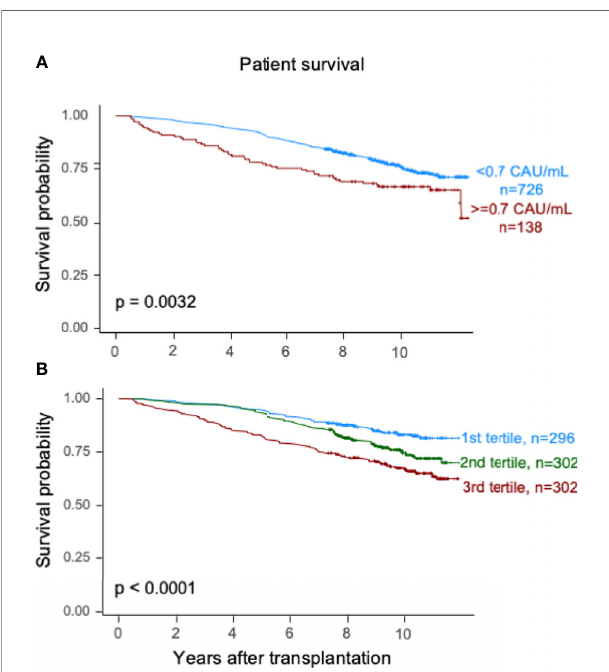
FIGURE 2 | Kaplan – Meier estimates of overall patient survival after kidney transplantation according to plasma terminal C5b-9 complement complex (TCC) concentration 10 weeks after transplantation; (A) cut point of <0.7 CAU/ml and (B) tertiles.